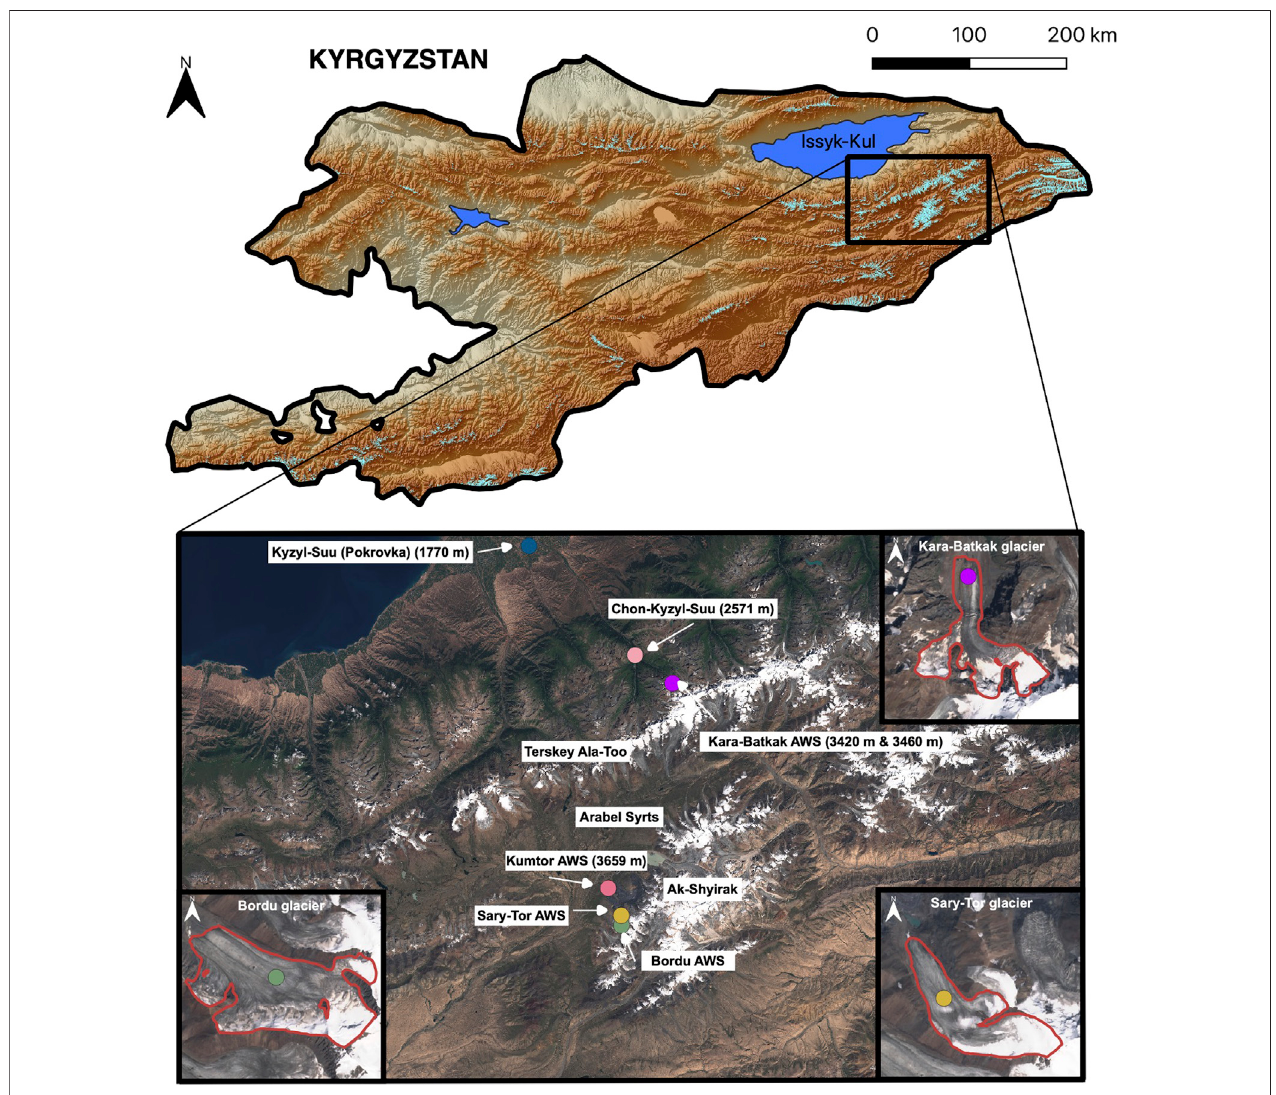
FIGURE1| Locationoftheautomaticweatherstations(AWS)onandnearbytherespectiveglaciersusedinthisstudy.ThesatelliteimageisacompositeSentinel-2 true colour image from 11 – 13 August 2019.